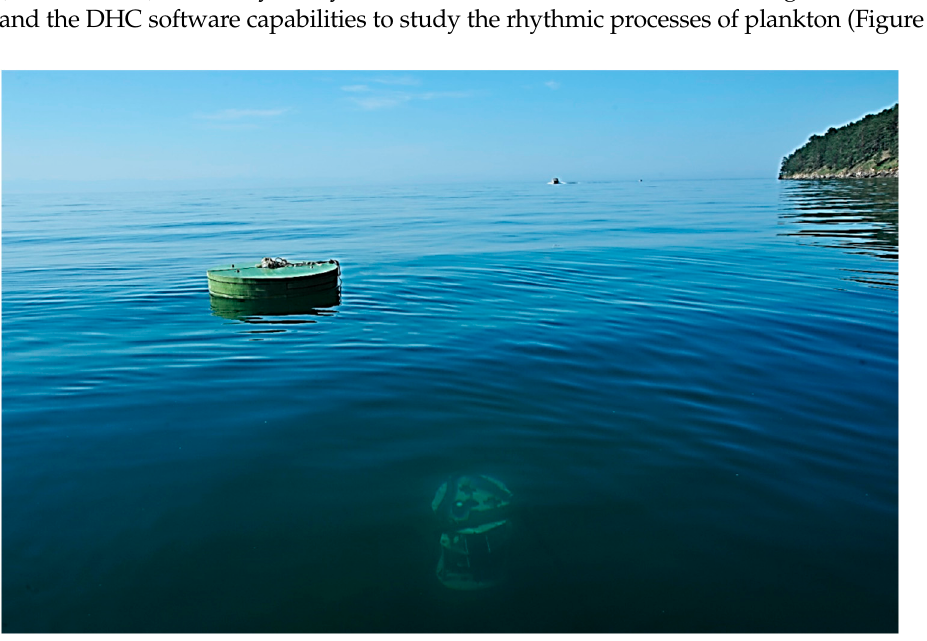
Figure 2. DHC FOCL probe station at the point with coordinates 51°53,952 ′ N 105°03,834 ′ E, Lake Baikal.